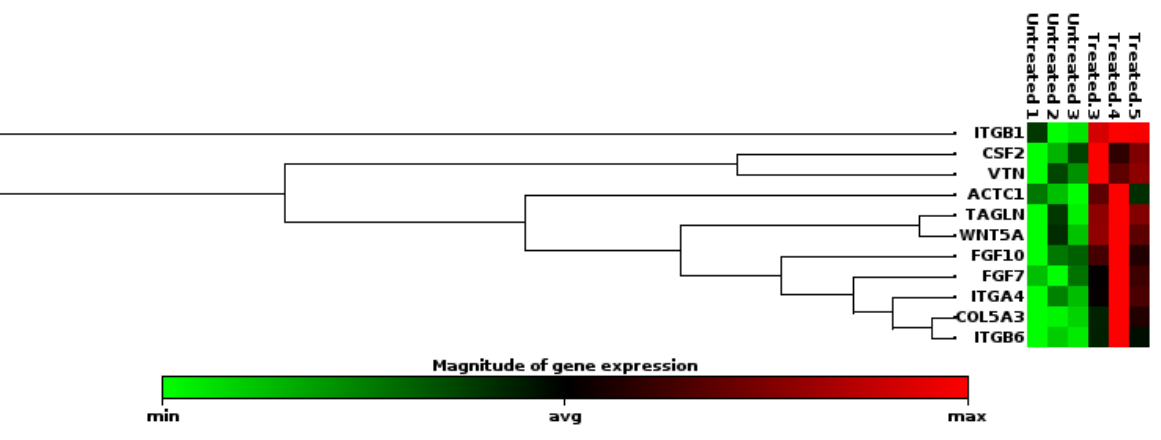
Figure 7. Clustergram of DEGs expressed in C. orbiculata water extract-treated KMST-6 cells.